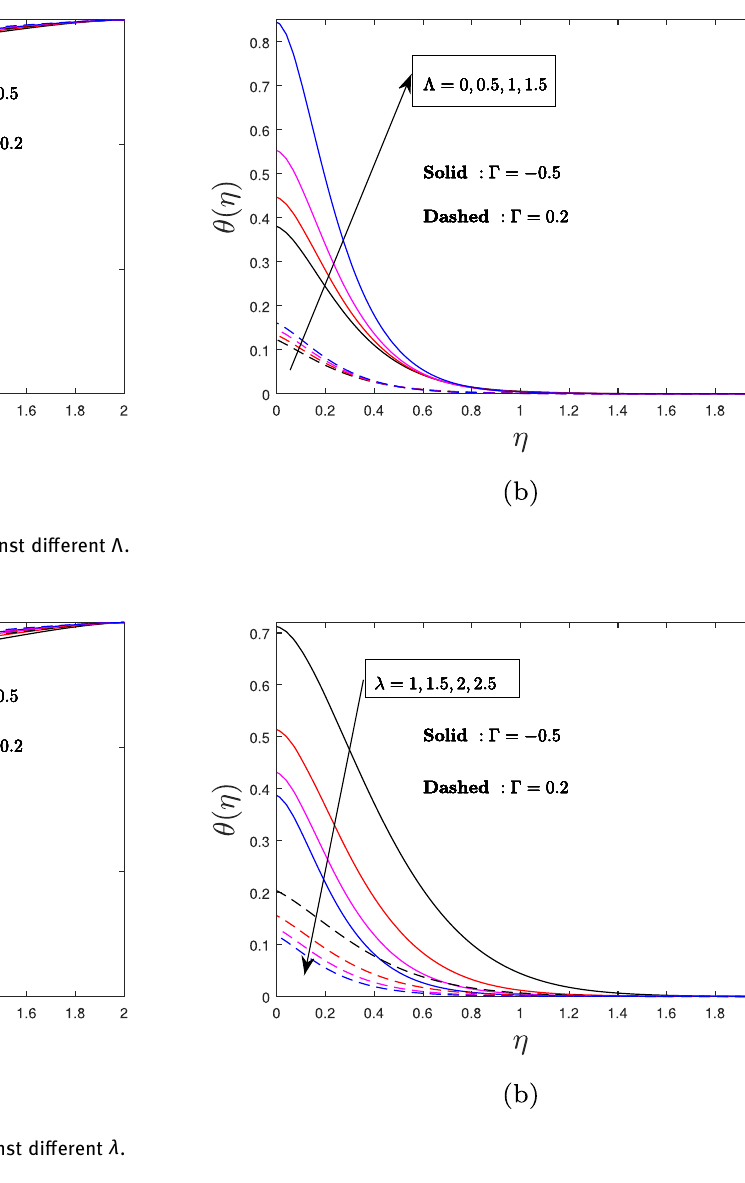
Figure 10 elucidates the impact of fl uid variable phy - sical properties on both velocity and temperature distri - butions. In both cases of stretching and shrinking Riga plate, it is clear that increment in the viscosity variant parameter leads to augmentation in the non - dimensional fl ow and temperature. This is due to the fact that an increase in the variable viscosity parameter has a poten - tial of increasing the temperature di ff erence T T w ( ) − thus weakening the third - grade fl uid bond and mini - mizing the strength of dynamic viscosity of the non - New - tonian fl uid. Thus, both velocity and thermal boundary layer thicknesses are improved, leading to upsurge in MNF velocity and temperature. Figure 11 stipulates the repercussions of suction parameter ( λ 0 > ) on both